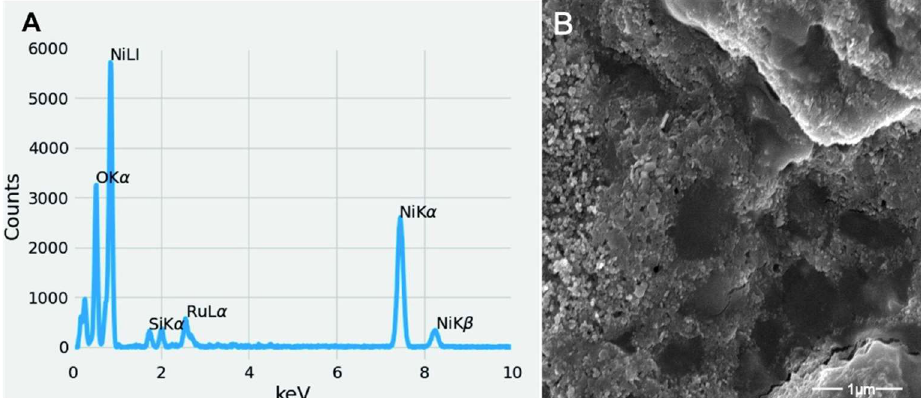
Figure 6. EDX analysis of the cluster formed in a medium containing 5 mM nickel oxide NPs and P. aeruginosa after 32 h of cultivation. The results of EDX analysis show that the cluster formed consisted mainly of nickel and oxygen ( A ). SEM enlargement of cluster ( B